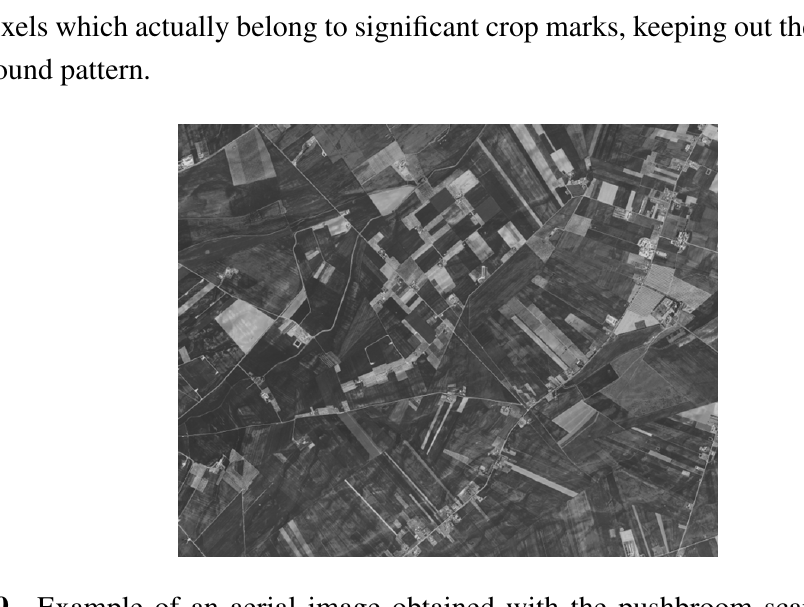
Figure 9. Example of an aerial image obtained with the pushbroom scanner ADS40 by Leica Geosystems.